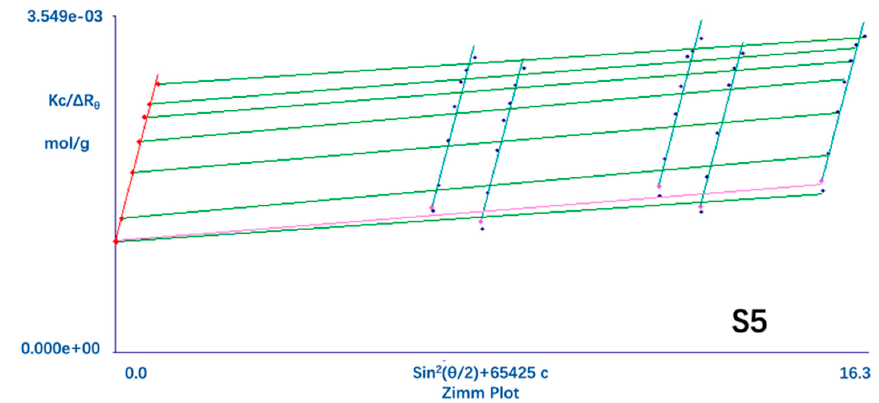
Figure 5. Zimm plots for S1, S2, S3, S4 and S5 in mixed formamide/water (1:1). Table 3. Structural parameters of the five polymers in mixed formamide/water (1:1) at 25 ° C. Sample